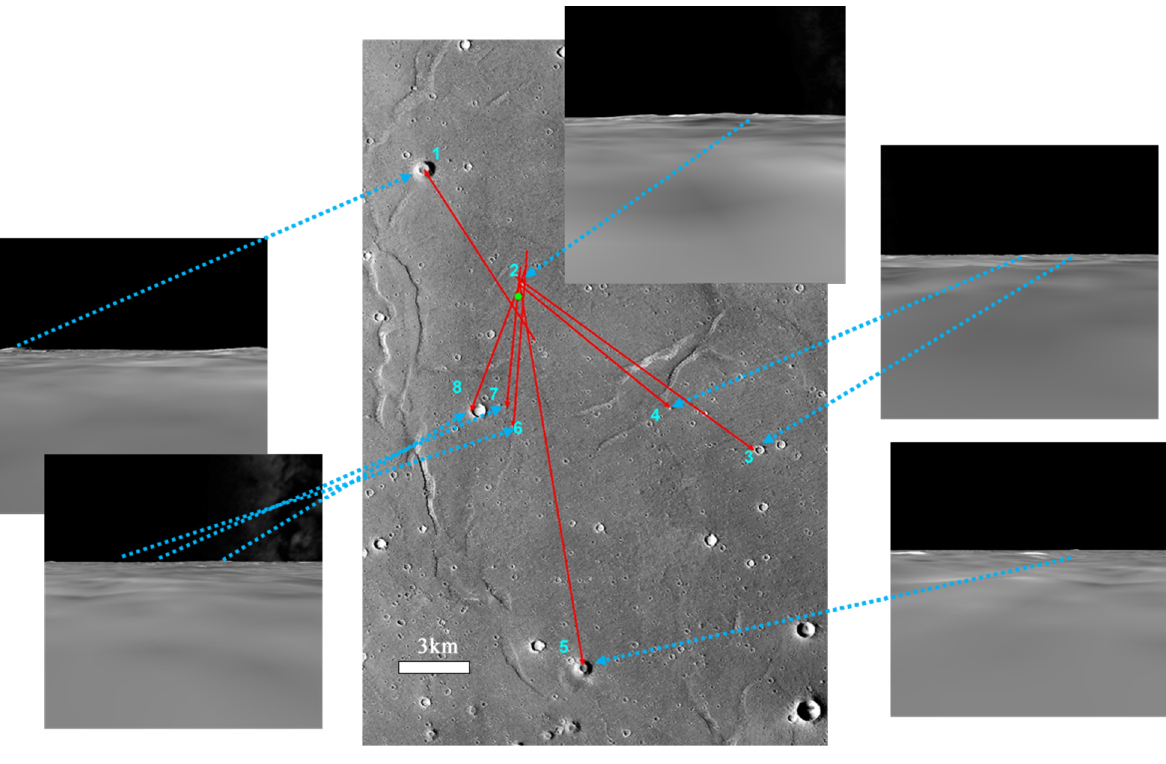
Figure 6. Initial localization result based on the landmark triangulation method. The central image is the HiRIC DOM, the others are the simulated images; the green point is the lander location; the red lines are the azimuth lines of the landmarks; the blue number is the index of landmark extracted in NaTeCam panorama in Figure 5.